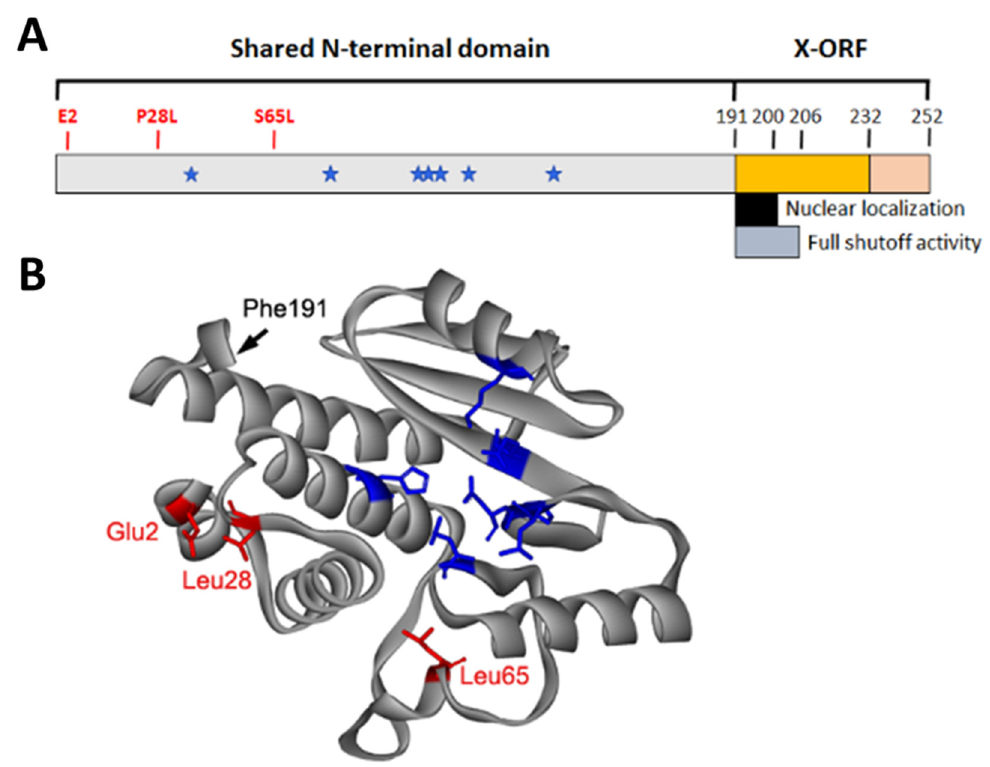
Figure 2. Structure of the IAV PA-X protein. ( A ) Schematic diagram of PA-X showing functional domains. Residues within the shared N-terminal domain known to affect PA-X shutoff activity are shown in red. Blue stars indicate the location of residues involved in endonuclease activity as previously shown in Figure 1. ( B ) Crystal structure of H3N2 PA N-terminal domain (PDB: 2W69) showing the location of key residues highlighted in (A) and the beginning of the X open reading frame (X-ORF) at Phe 191 [27].